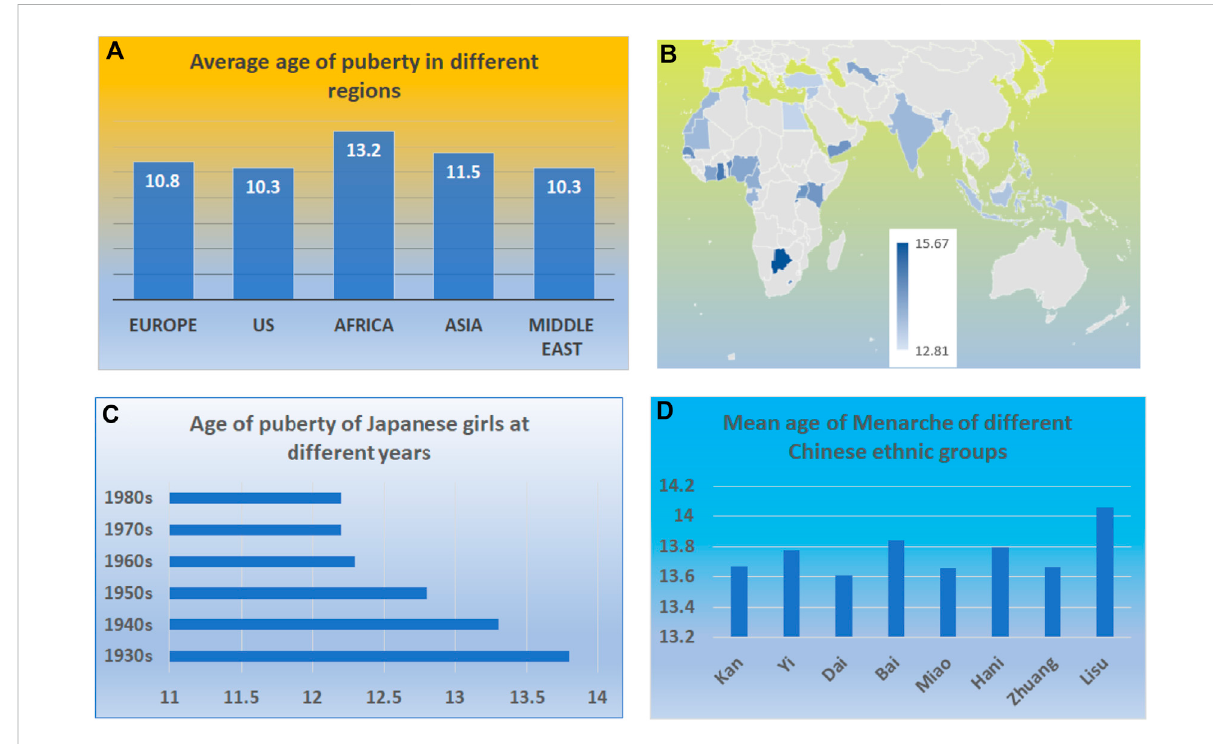
FIGURE 2 Variation of ages at puberty in the human population. (A) The variations in ages of puberty among different continents. (B) The variations in the agesofpubertyamongdifferentcountriesamongmiddle-andlow-incomecountries. (C) ThevariationsintheagesofpubertyamongJapanesegirls in different years. (D) The variations in the ages of puberty among different Chinese ethnic